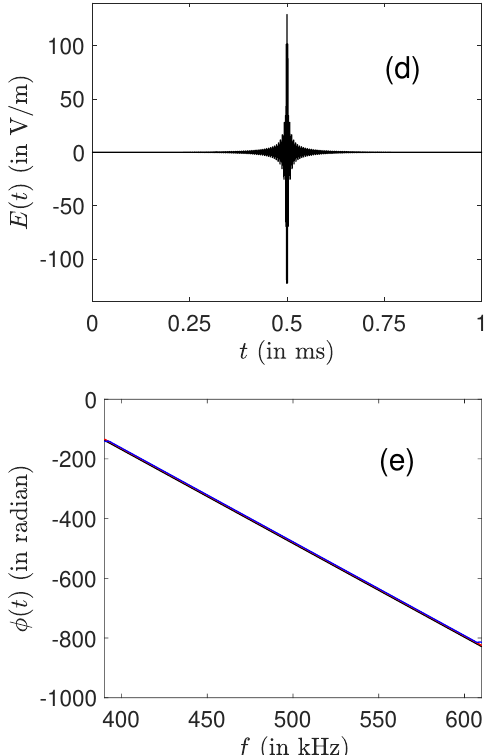
Figure 1. Comparison between the optimal and the SWIFT approaches for the robust control of an ensemble of ions in the frequency range [ 400,600 ] kHz. The small insert is a zoom of the profile around the frequency f = 600 kHz. ( a , e ) The evolution of the final radius and phase as a function of f . Note that an arbitrary constant has been added to the phase in order to superimpose the curves (the three lines are practically indistinguishable in ( e )). The black, blue (dark gray) and red (light gray) solid lines depict, respectively, the optimal solutions computed without and with the RWA and the SWIFT pulse. The SWIFT and optimal control laws are plotted in ( b , c ) (optimal without RWA) and ( d ) (optimal with RWA). The number of discretized frequency points is set to 601 in the optimization process in the range [ 350,650 ] kHz.